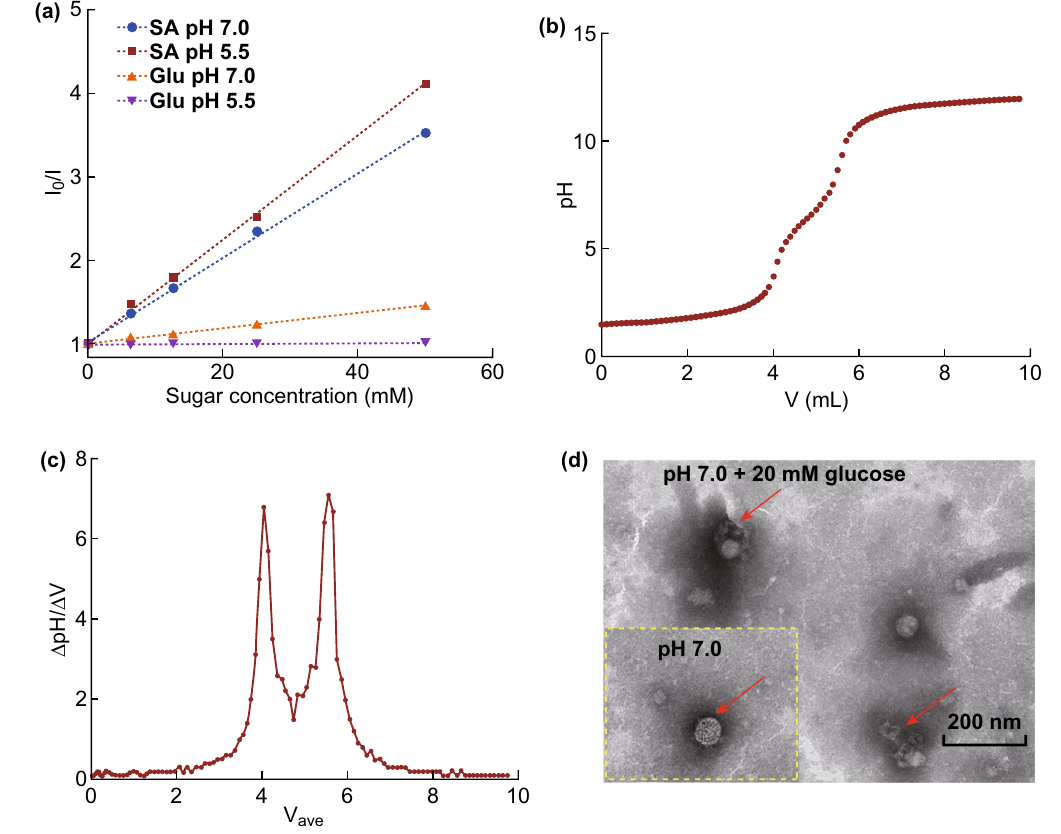
Figure 3 Stimuli-triggered physicochemical property transition. a Relative fluorescence as a function of sugar concentration for SPCS meas- ured in phosphate buffer (0.1 M) at room temperature ( λ ex = 371 nm and λ em = 425 nm) at pH 7.0 and 5.5. I 0 and I represent the fluorescence intensity in absence and presence of sugar. b Titration curve against pH was measured at room temperature. c pKa of SPCS calculated by stair differential coefficient. d TEM images of SPCS/DIC micelles with and without the presence of